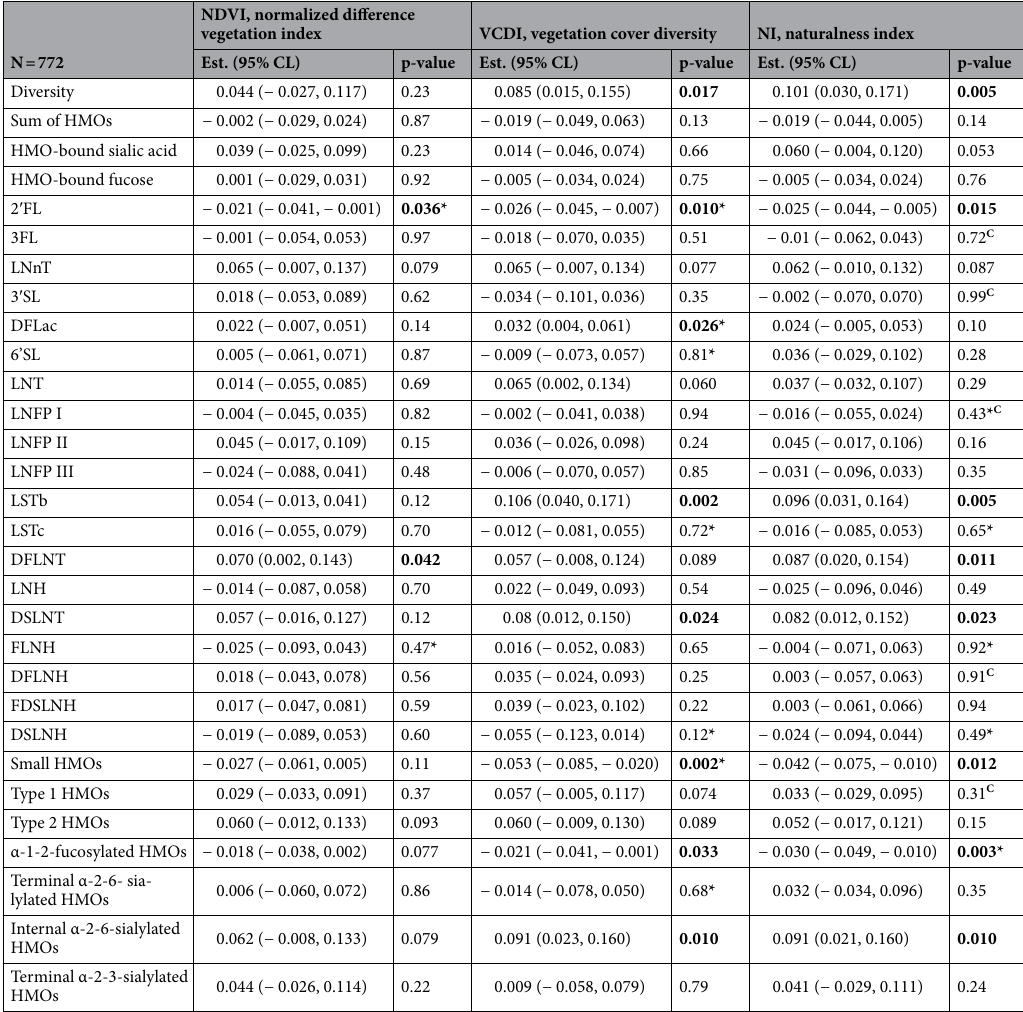
Table 2. Adjusted standardized estimates (95% confidence interval) in HMO diversity, individual HMO concentrations and HMO structural groups (nmol/mL) per one SD increase in residential green environment (exposure) variables. Standardization means that both the exposure and outcome have been standardized (log scale in all other outcome variables expect Diversity, which is in the original scale). The exposure variables were measured at the time of child was born (2008–2010) with 750 m × 750 m grid size around the homes of the families. Statistics are given for main effects and significant values are in bold. * Indicates a significant interaction between the exposure variable and secretor status (p < 0.05). C Indicates a significant curvilinear association with the exposure variable (p < 0.05). Models were adjusted for secretor status, season, lactation time, lactation status, child sex, child birth weight, birth mode, duration of pregnancy, number of previous births, marital status, occupation, education, smoking, pre-pregnancy BMI, diseases. 2 ′